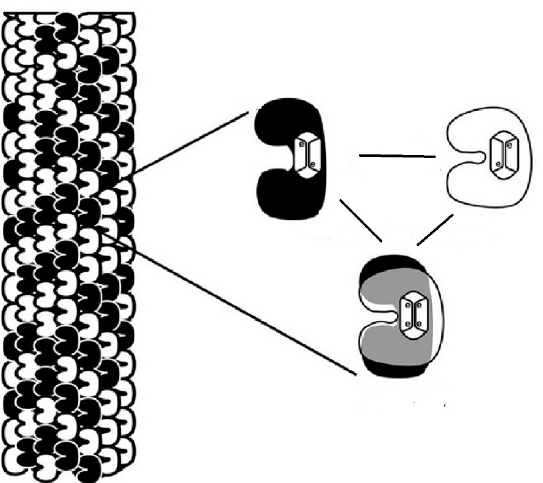
Figure 4. Symbolic presentation of a microtubule composed of tubulin dimers existing in three different states. Symbolic presentation of tubulin dimers, which due to the positions of delocalized electrons can be in two different states and additionally in a quantum superposition state. On the left a symbolic presentation of a microtubule composed of tubulin dimers existing in three different states.